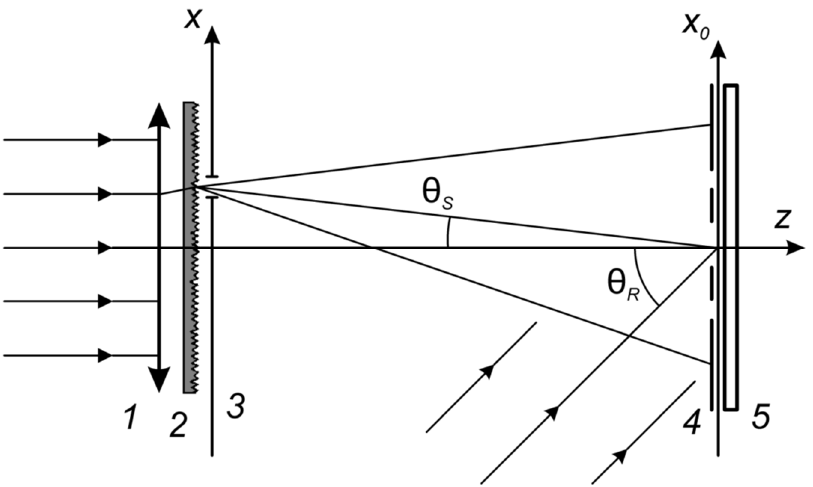
Figure 3. Schematic of recording rainbow focused image holograms. Collimated beam 1 through a random phase mask 2 and a horizontal slit 3 forms, along with transparent 4 , the object beam onto hologram 5 .